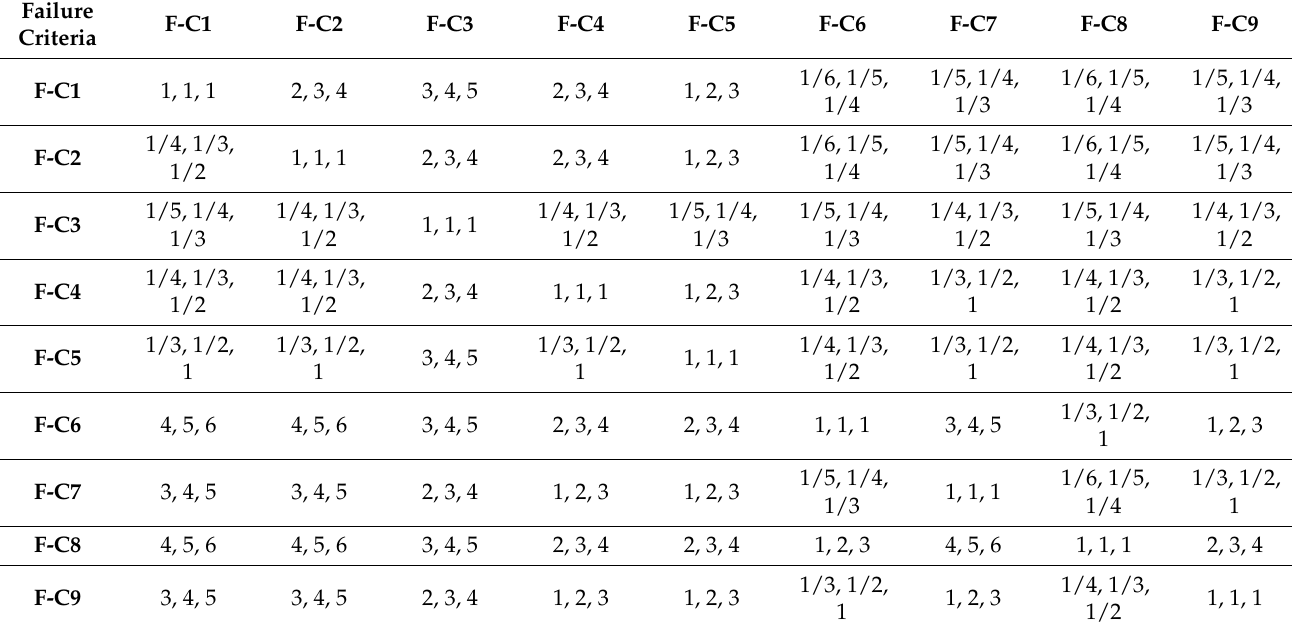
Table 9. The developed F-PCMs table based on the Saaty’s Scale in Table 4.